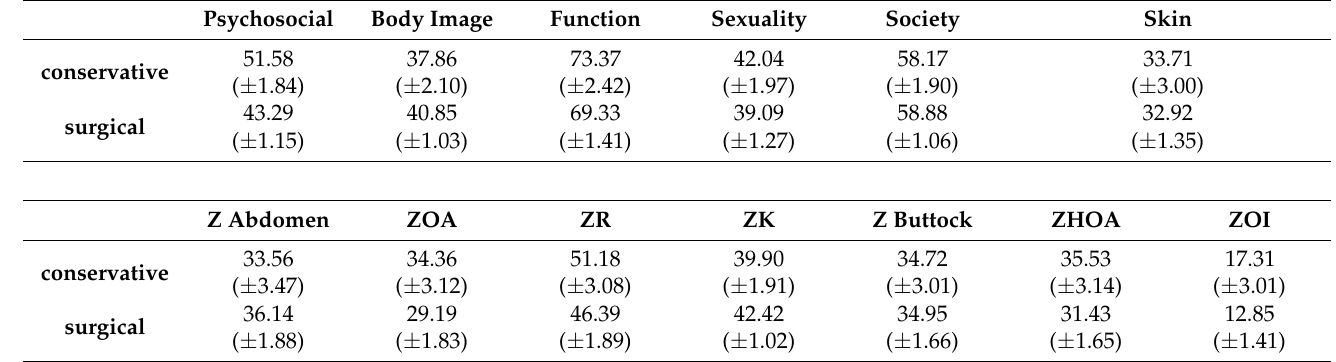
Figure 1. Comparison of the quality of life in the subscales “psychosocial”, “sexuality” and “satisfaction-upper arms” of the two patient groups weight loss by conservative measures vs. weight loss by surgical measures. The box plots represent the median, the interquartile range and the distribution. Statistical differences were examined using the Wilcoxon test. The significance level is * p < 0. Table 2. Presentation of the mean BODY-Q values in the categories psychosocial, body image, function, sexuality, society and skin, satisfaction-abdomen (Z Abdomen), satisfaction-upper arms (ZOA), satisfaction-back (ZR), satisfaction-body (ZK), satisfaction-buttocks (Z Buttock), satisfaction- hips and outer thighs (ZHOA), satisfaction-inner thighs (ZOI) for the groups weight reduction by means of conservative and surgical measures, with standard deviation (SD) in